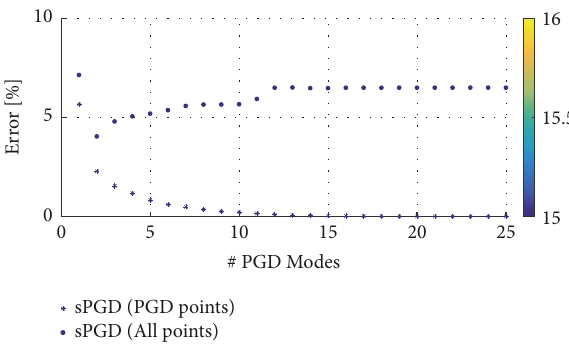
Figure 3: E L (points) and E P (asterisk) versus the number of modes for 𝑓 1 (𝑥, 𝑦) , # P = 100 , # L = 1000 . No modal adaptivity.